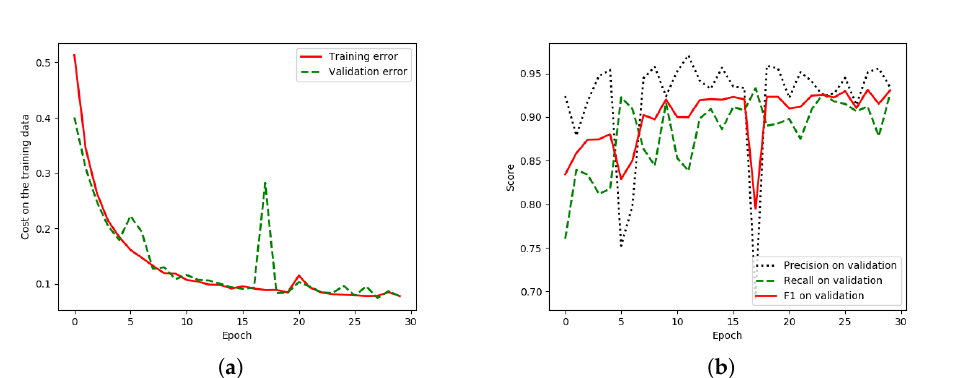
Figure 20. Graph (learning curves) on ISPRS Vaihingen data set of the proposed approach, “HR-GCN-FF-DA”; x refers to epochs, and y refers to different measures ( a ) Plot of model loss (cross-entropy) on training and validation corpora; ( b ) performance plot on the validation